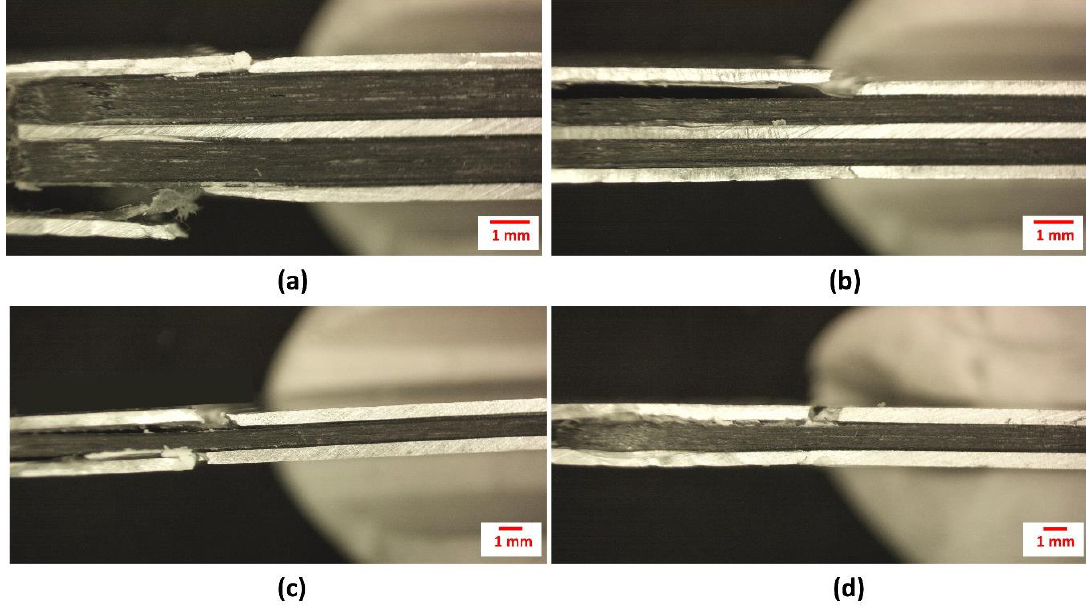
Figure 6. Tensile strength of the CF-FMLs and its constituent materials.